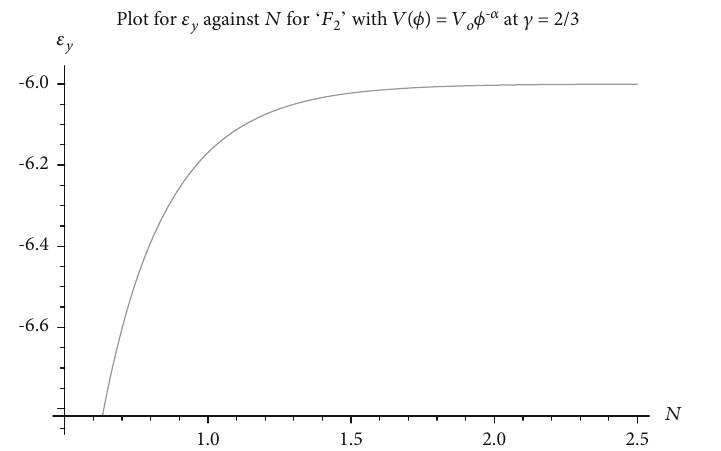
Figure 21: Shows the variation of perturbations along the y -axis ( ϵ